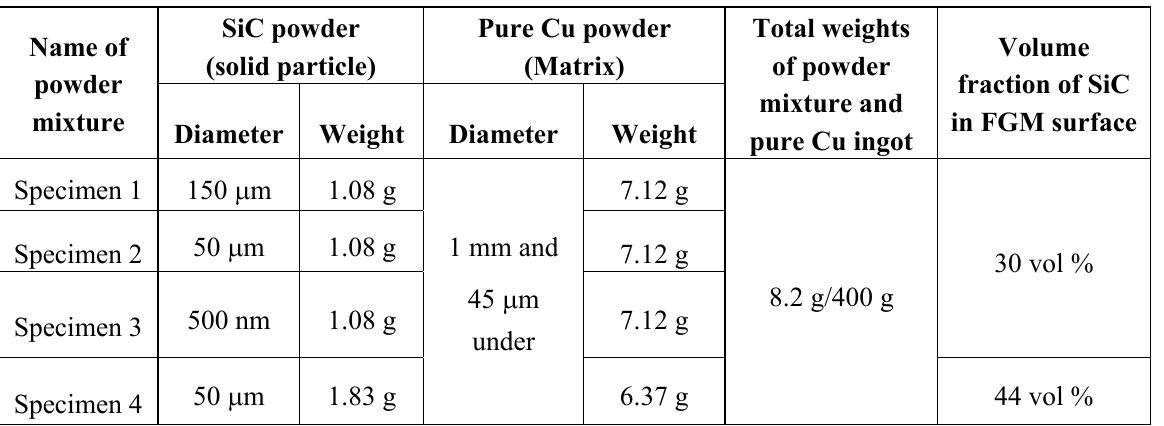
Table 1. Details of fabricated Cu/SiC